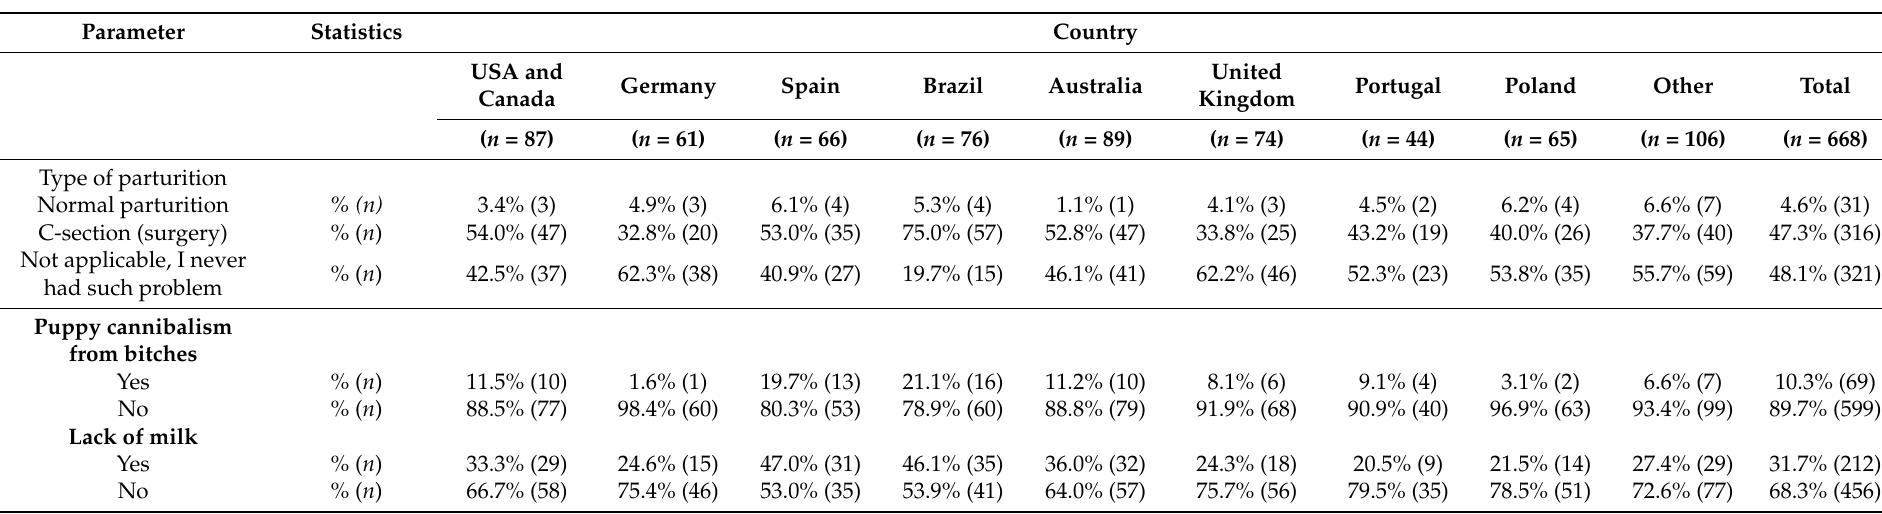
Table 3. Inappropriate maternal behaviour according to type of parturition, puppy cannibalism and lack of presence of milk based on different countries (n =